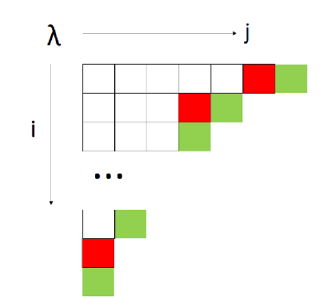
Figure 3 . Outer boundary (colored in green) and inner boundary (colored in red) of a Young diagram (cid:21)